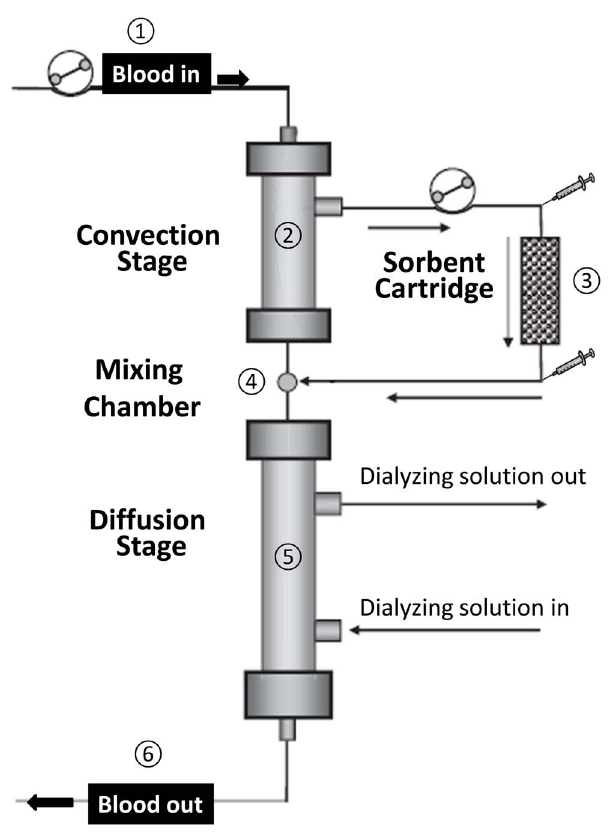
Figure 1. Schematic representation of the HFR apparatus. The figure shows the main components of the HFR Supra system (Bellco, Mirandola, Italy) used in the study. 1-The blood of the patient is pumped into the top filter (the convection stage). 2-In this stage of the HFR apparatus, the blood is filtered by a high flux polyethersulfone membrane. 3-The ultrafiltrate produced in the convection stage is pumped by a second pump through a sorbent cartridge where hydrophobic waste solutes are retained. The small syringes indicate the points of the systems where rubber stopper for UF sample collection are located. 4-The blood coming from the convection stage and the UF coming from the cartridge are mixed in a chamber located between the two filters 5-This ‘‘reconstituted’’ blood enters the bottom filter (the diffusion stage) where it is undergoes dialytic treatment (both diffusion and ultrafiltration for weight loss) with a low flux polyethersulfone membrane. 6-The cleared blood is returned to the patient. (Modified form an original image kindly provided by Dr. G. Palladino, Bellco, Mirandola, Italy).